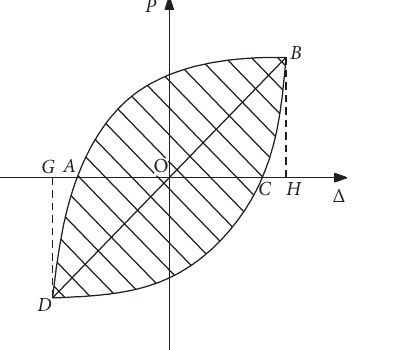
Figure 11: P − Δ hysteretic curve, representing the energy-con- suming capacity of the specimen.